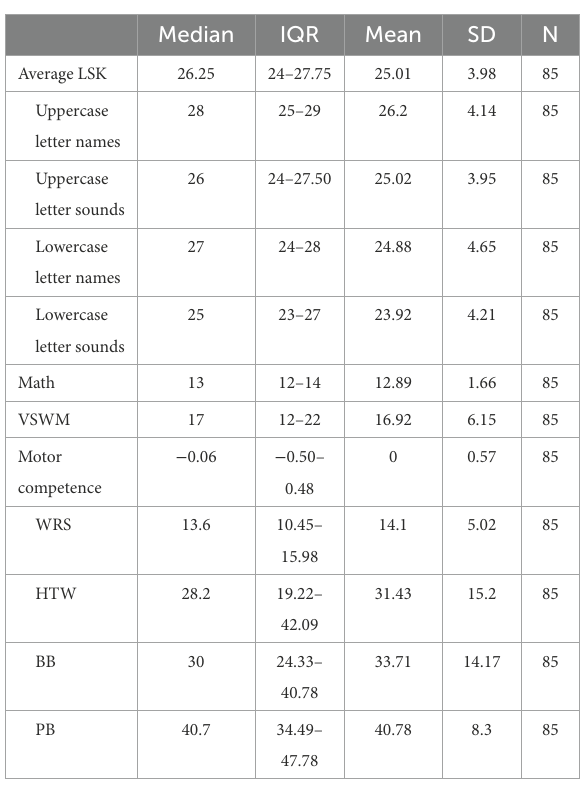
TABLE 1 Descriptive statistics of LSK, math competence, VSWM, and motor competence in first